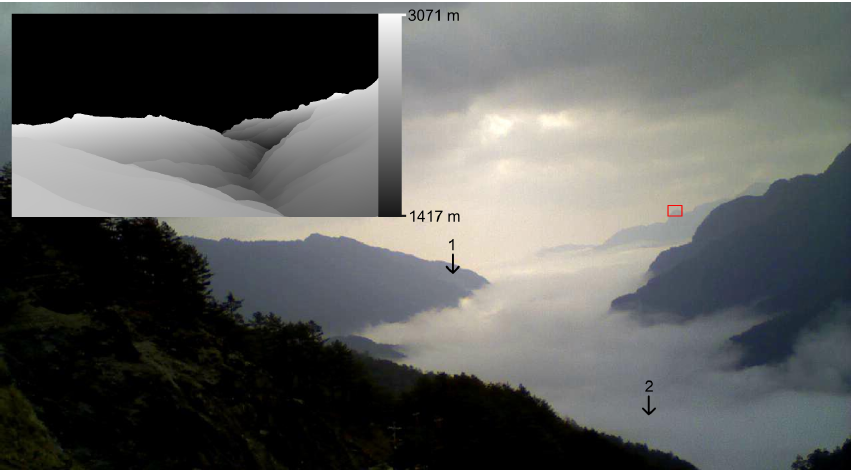
Figure 4. View of the main cam on 15 March 2013, 10:14UTC + 8 (main picture) and the DEM projected to the view of the main cam (inset). The mountain top marked by a red square is used in Sect. 4.3.3 for the assessment of errors caused by a misfit between the real camera and the virtual camera. See Sect. 4.2.3 for explanation of the